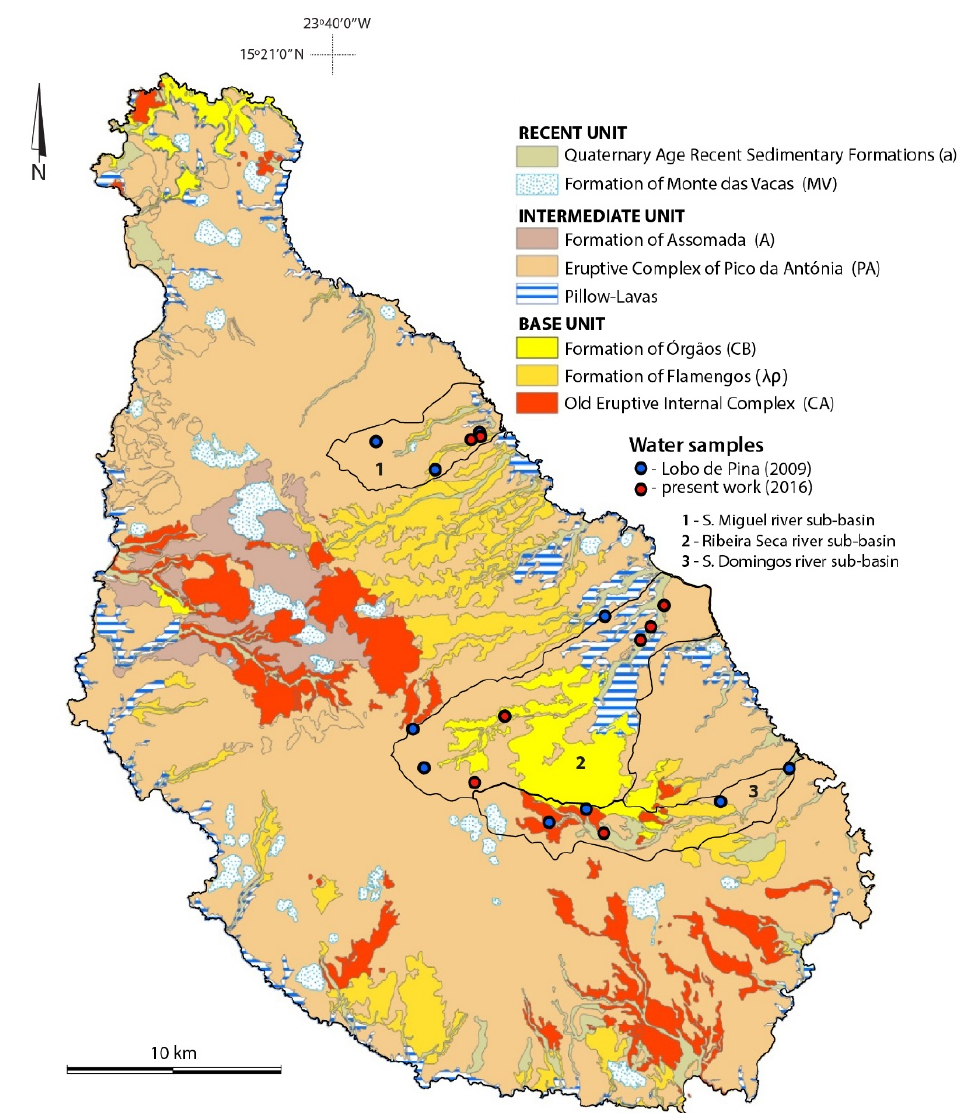
Figure 4. Map of hydrogeological units (adapted from Cape Verde geological map to the scale 1:25,000 [29,41,42]. The circles represent the location of the water samples in the river sub-basins: 1—S. Miguel, 2—Ribeira Seca and 3—S. Domingos.